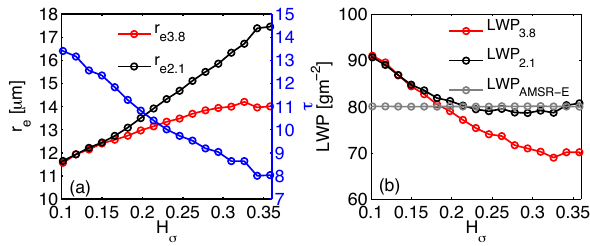
Fig. 5: a) Mean r e3.8 , r e2.1 , and τ binned by AMSR-E LWP and H σ , and subsequently 536 Fig. 5. (a) Mean r e 3 . 8 , r e 2 . 1 , and τ binned by AMSR-E LWP and H σ , and subsequently averaged for all LWP bins (red, black, and averaged for all LWP bins (red, black, and blue lines, respectively) for cloudy scenes 537 blue lines, respectively) for cloudy scenes only (CF > 98%). (b) As only (CF >98%). b) As in Fig. 5a, but for LWP (AMSR-E LWP is constant at 80 g m -2 by 538 in (a) , but for LWP (AMSR-E LWP is constant at 80gm − 2 by de- design). 539 540